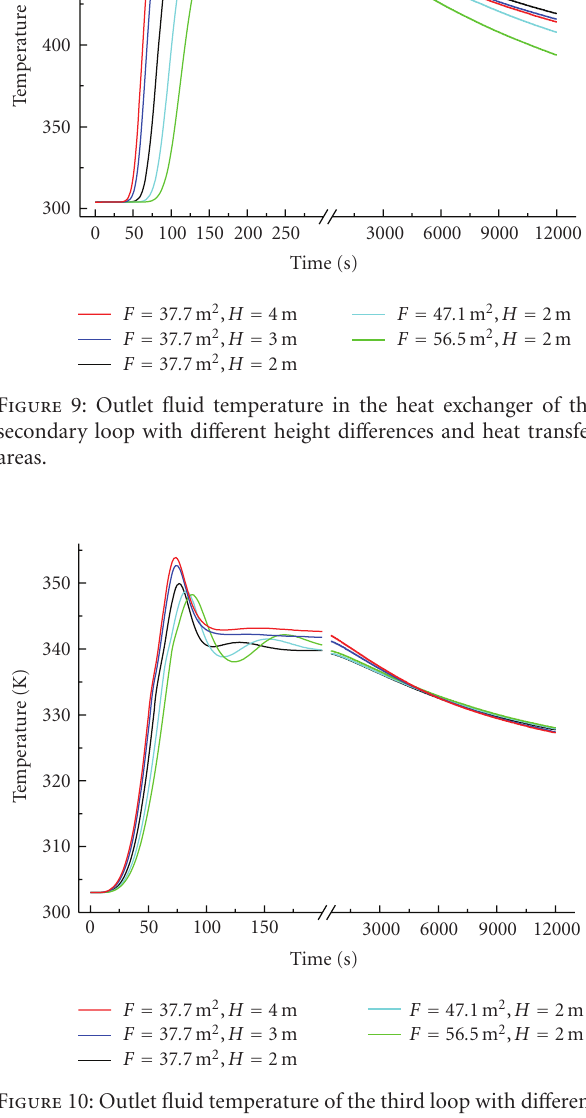
Figure 10: Outlet fluid temperature of the third loop with di ff erent height di ff erences and heat transfer